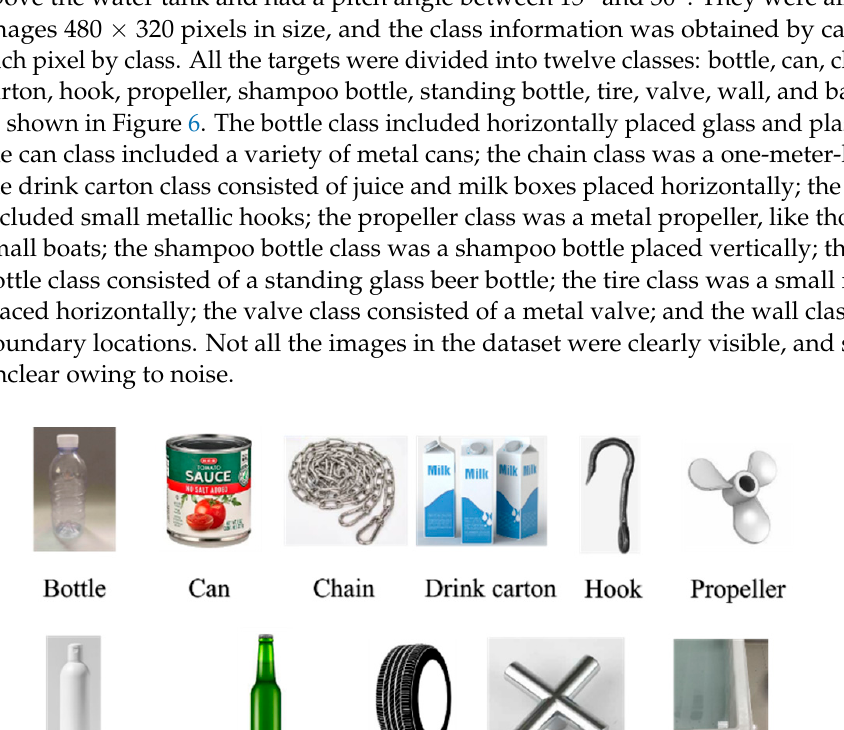
Figure 6. Examples of objects belonging to various classes. The data were divided randomly to provide 1000 images in the train set, 251 images in the validation set, and 617 images in the test set. The random division ensured that the data were evenly distributed across each set, and the number of images from each class in each set is shown in Figure 7.